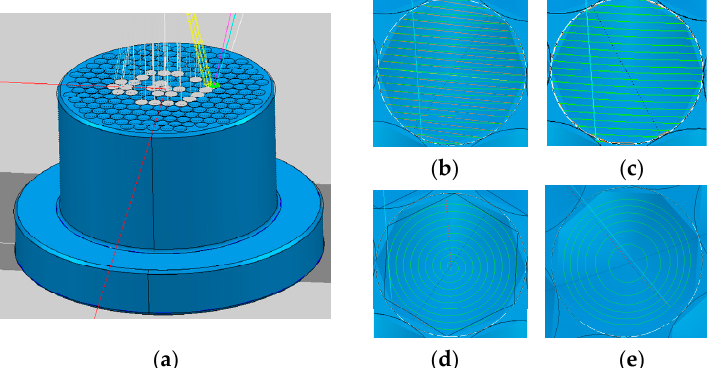
Figure 2. Tool path strategies for machining micro-lens array mold. ( a ) Micro-lens array mold; ( b ) single-direction raster tool paths; ( c ) raster tool paths; ( d ) 3D offset spiral tool paths; and ( e ) equal height finishing tool paths.